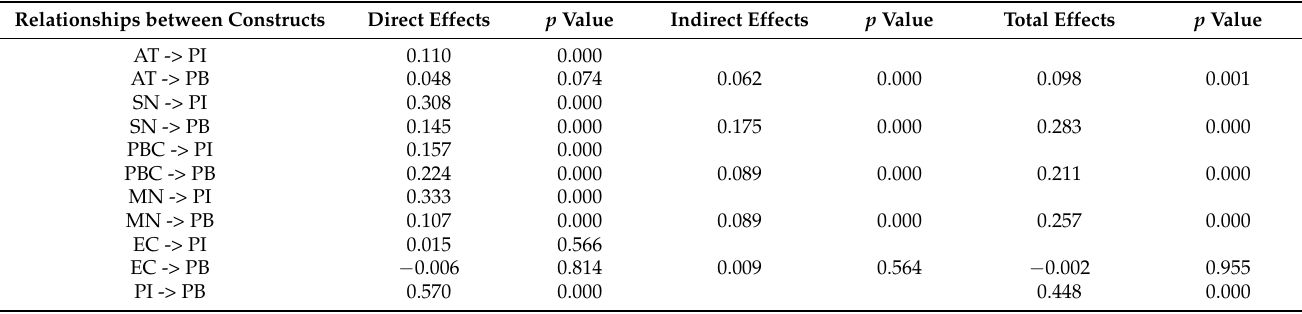
Table 6. Results of direct, indirect and total